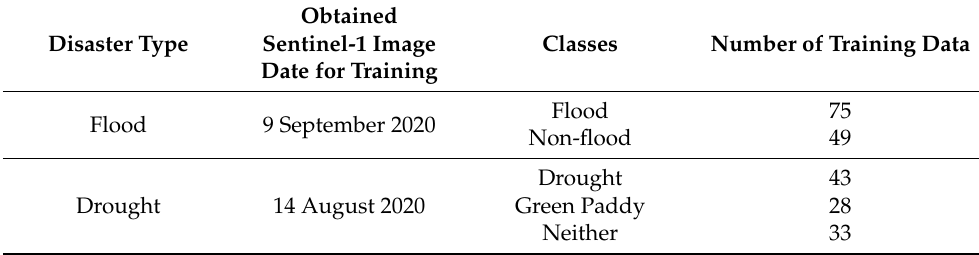
Table 2. Training classes and the number of training data used to classify flood and drought using CART classification on Sentinel-1 SAR GRD